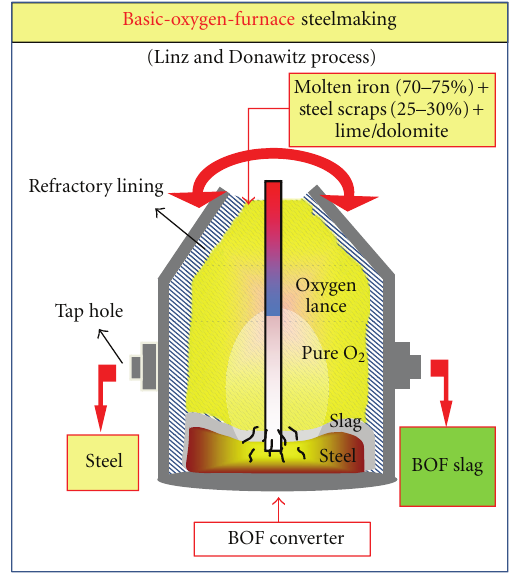
Figure 2: Schematic representation of the basic-oxygen furnace process [1,